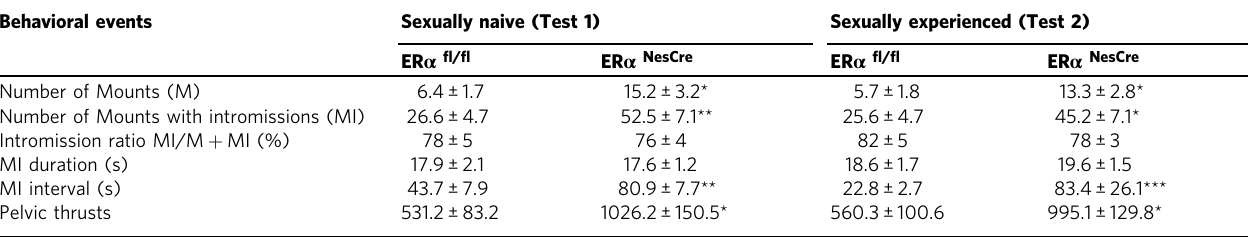
Table 1 Sexual behavior of gonadally intact ER α NesCre males.